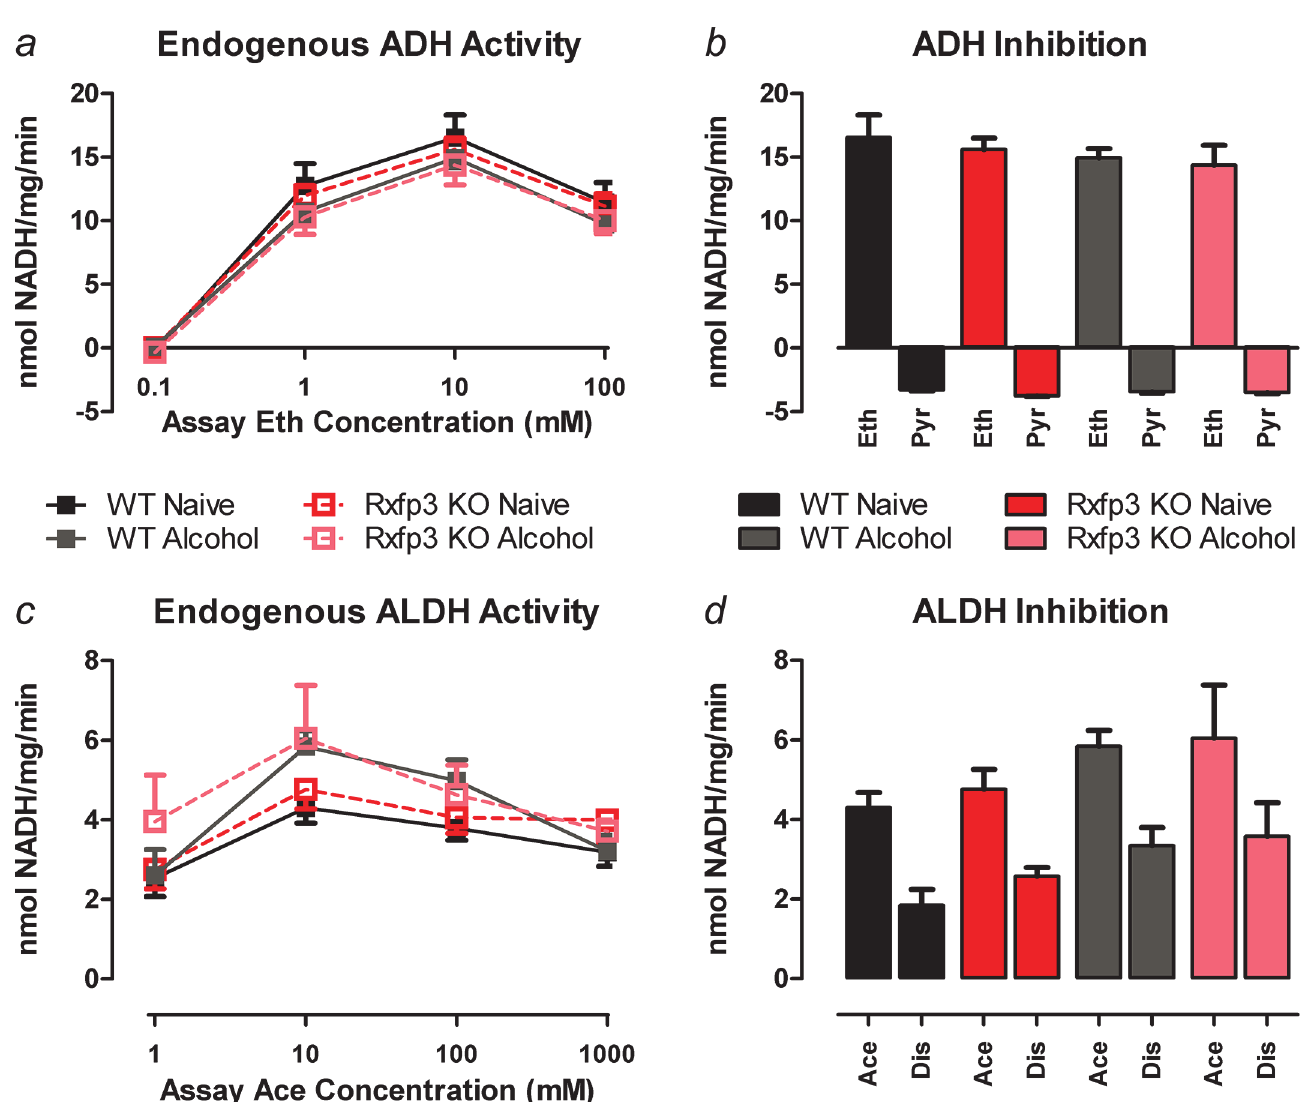
Fig 3. Alcohol and Aldehyde Dehydrogenase Activity. Endogenous ADH and ALDH activity in naive Rxfp3 KO (n = 7) and WT (n = 5) liver samples and liver preparations from Rxfp3 KO (n = 6) and WT (n = 6) mice that chronically consumed alcohol (5%-20% v/v) for 10 weeks, as measured by substrate- dependent increase in NADH absorbance. Nicotinamide adenine dinucleotide ( β -NADH) was produced from the reduction of β -NAD+. (a) Increase in β - NADH as a result of ADH activity in the cytosolic fraction over various assay ethanol (Eth) concentrations. (b) Impact of pyrazole (Pyr; 10 mM), a specific ADH inhibitor, on the increase in β -NADH produced by the addition of 10 mM ethanol, the assay ethanol concentration that elicited maximal ADH activity. (c) Increase in β -NADH as a result of ALDH activity in the mitochondrial fraction over various assay acetaldehyde (Ace) concentrations. (d) Impact of disulfiram (Dis; 0.1 mM), a specific ALDH inhibitor, on the increase in β -NADH produced by the addition of 10 mM acetaldehyde, the assay acetaldehyde concentration that elicited maximal ALDH activity. Data are presented as mean ± S.E.M.